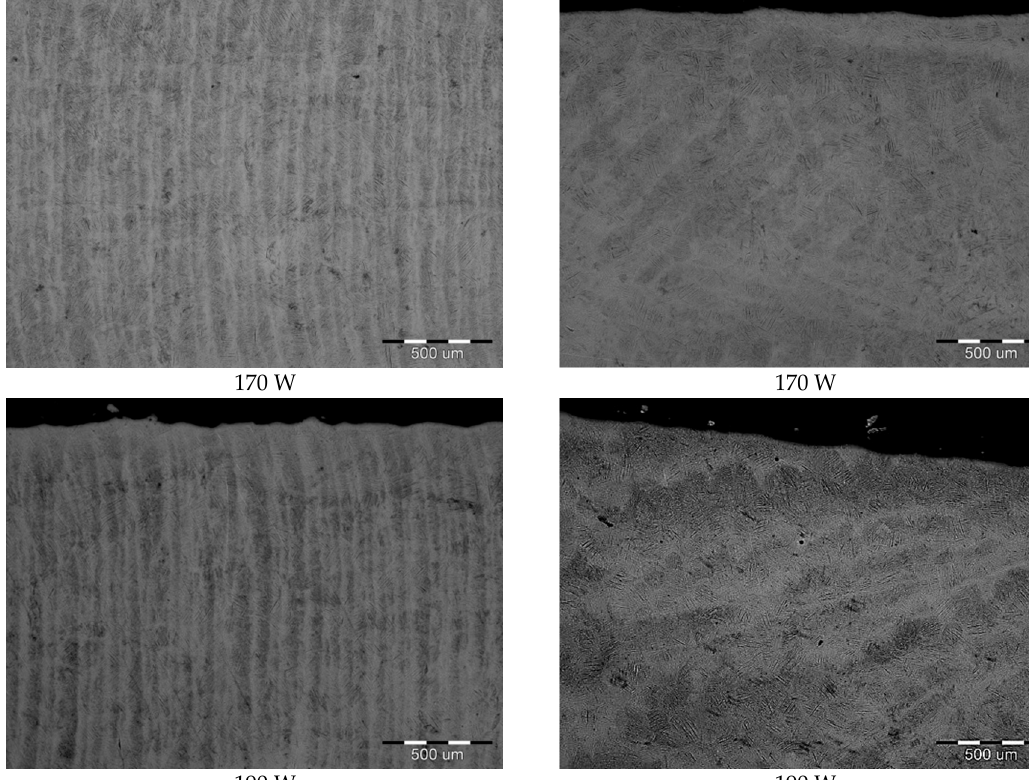
Figure 6. Microstructure of sintered materials, 50× mag., LM.